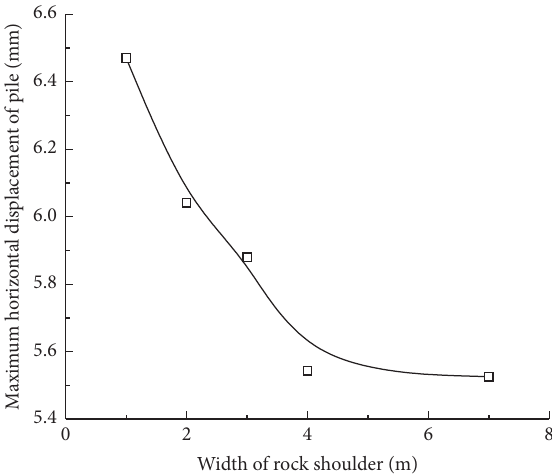
Figure 19: Influence of rock-socketed depth on horizontal displacement of the pile.